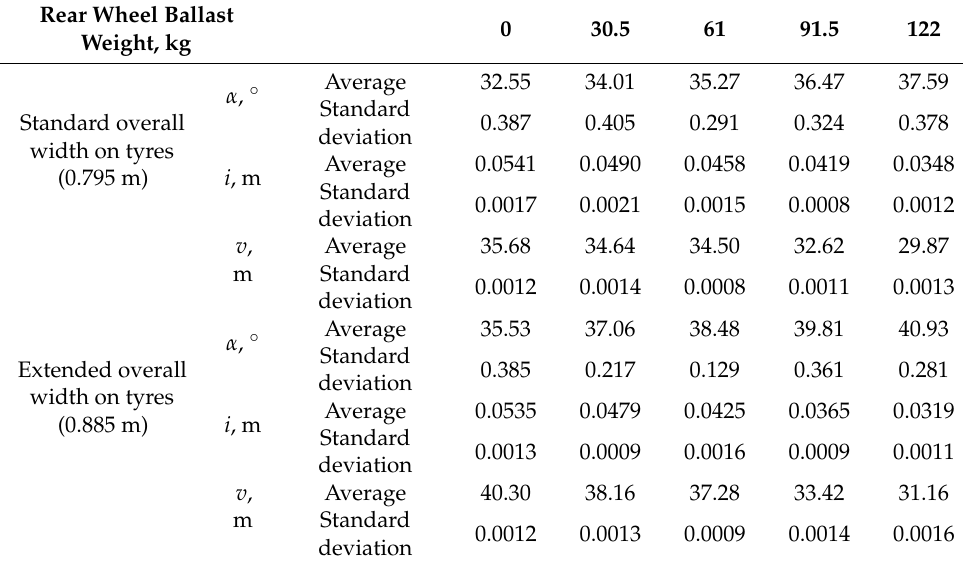
Table 3. Experimental